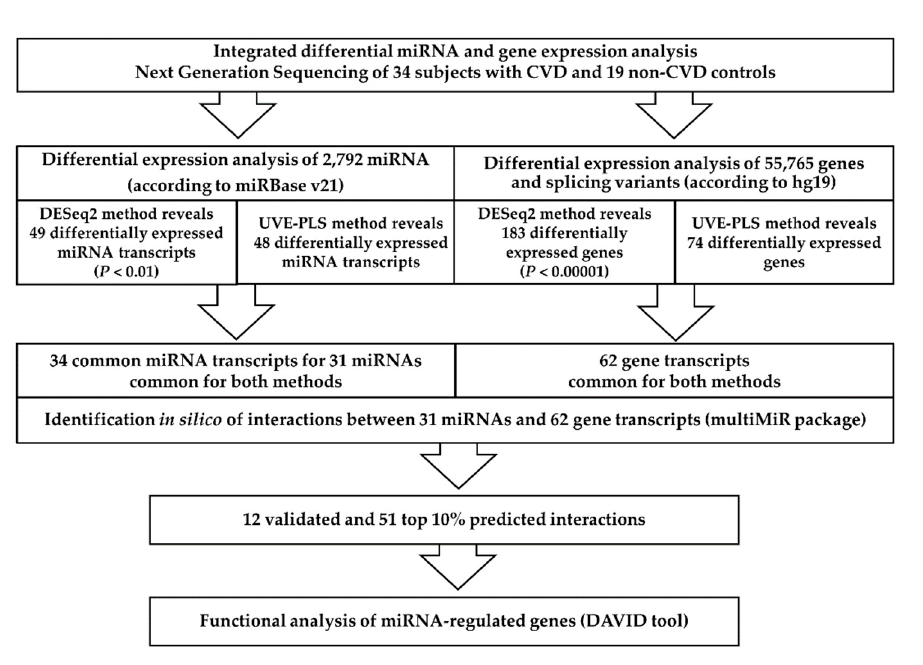
Figure 1. The scheme of the methodology applied in the study. CVD – chronic venous disease.